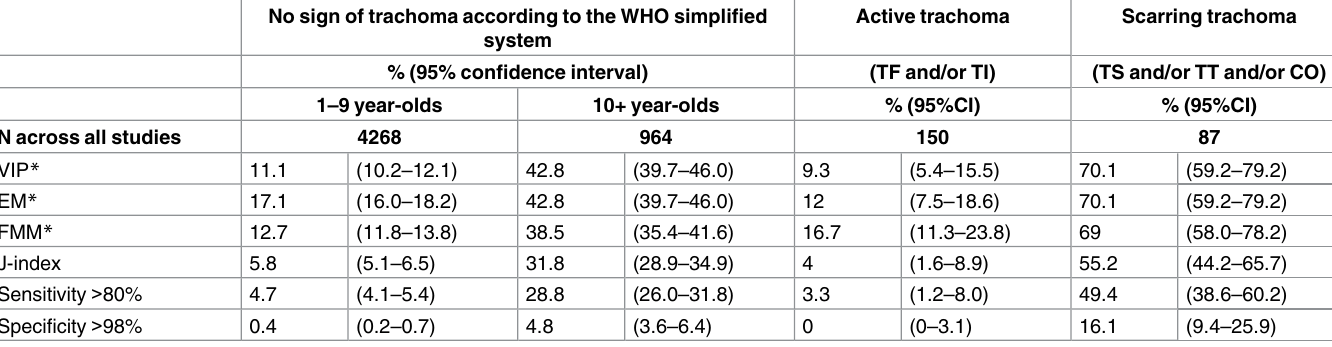
Table 4. Proportion of participants with different phenotypes considered seropositive by each threshold. No sign of trachoma according to the WHO simplified Active system